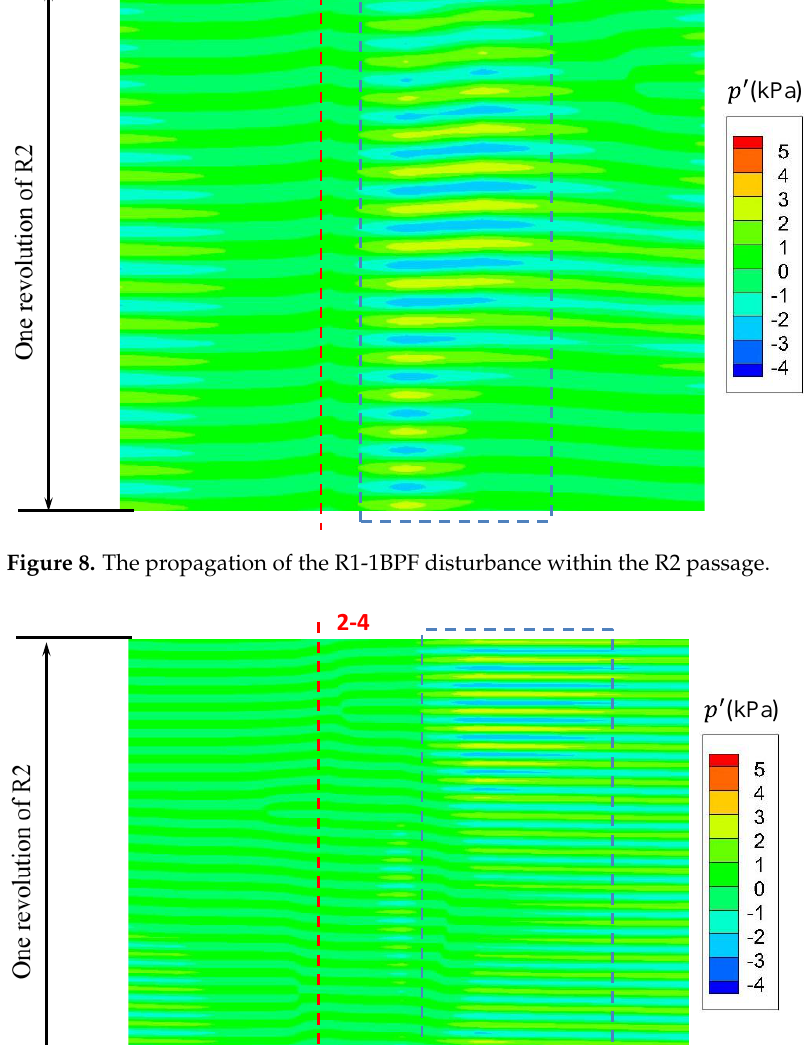
Figure 7 . The distribution of the pressure coefficient inside R2 .